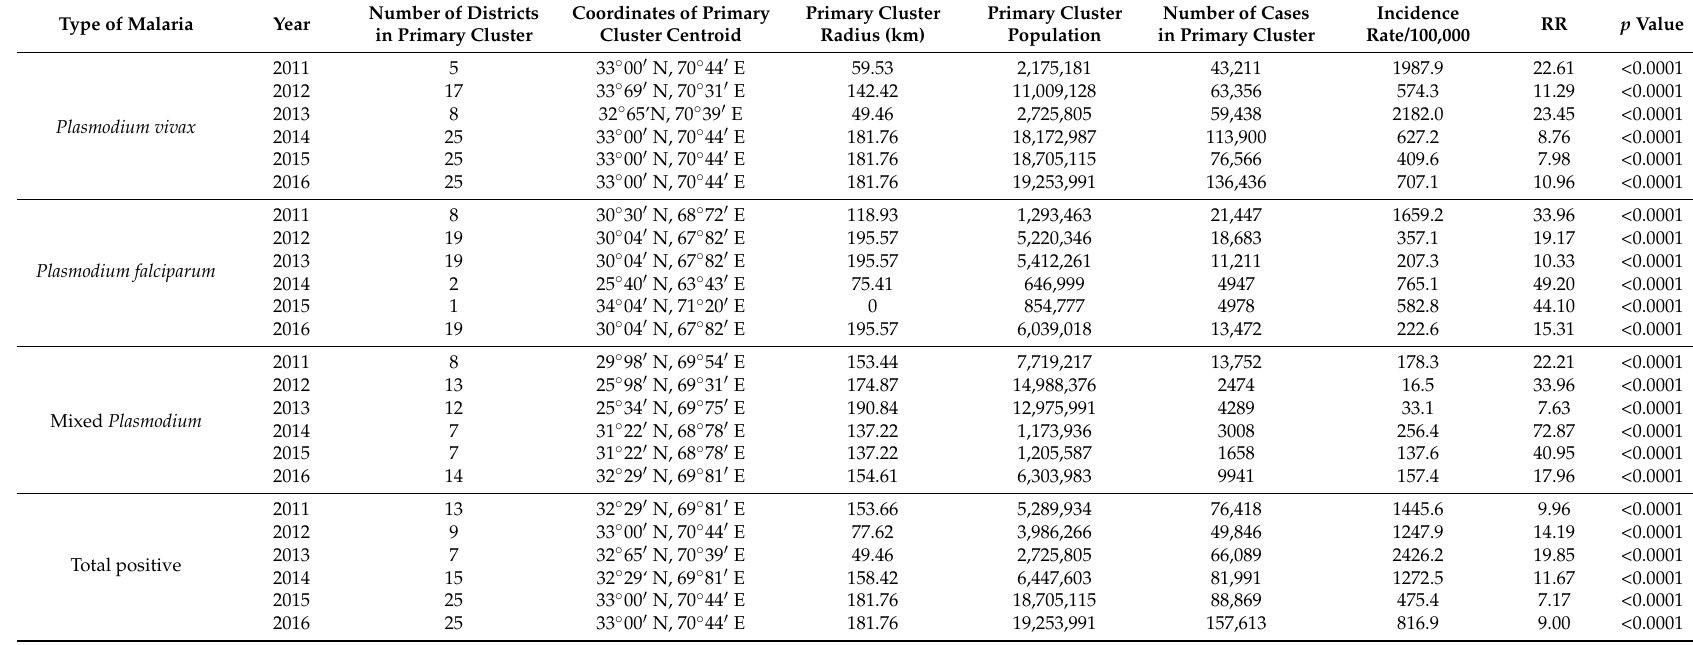
Table 2. Summary of primary high-risk clusters’ information of malaria by type at the district level in Pakistan,